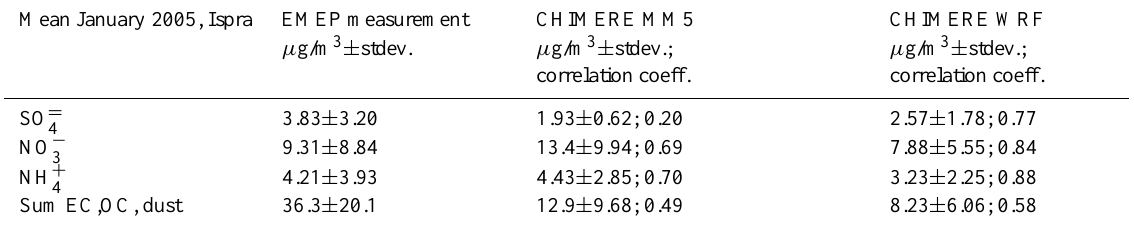
Table 5. Monthly mean measured concentrations for Ispra of SO = using MM5 and WRF, for January 2005, including the standard deviation and the temporal correlation